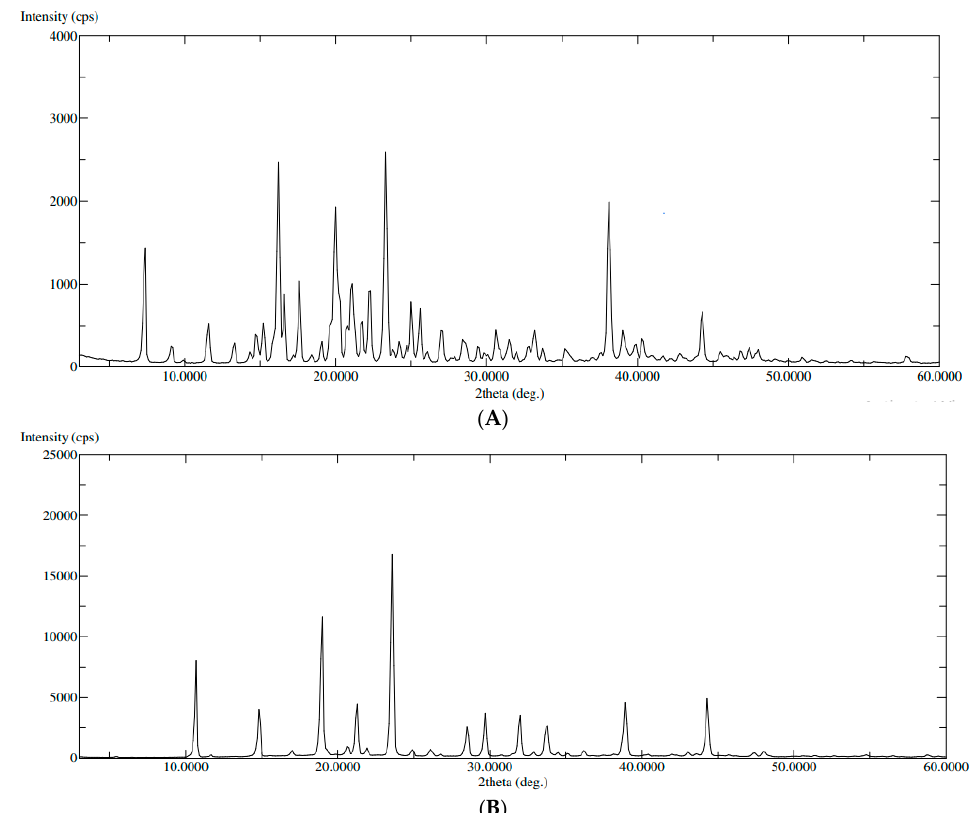
Figure 5. XRD of ( A ): pure QTF, ( B ): the optimized formula.